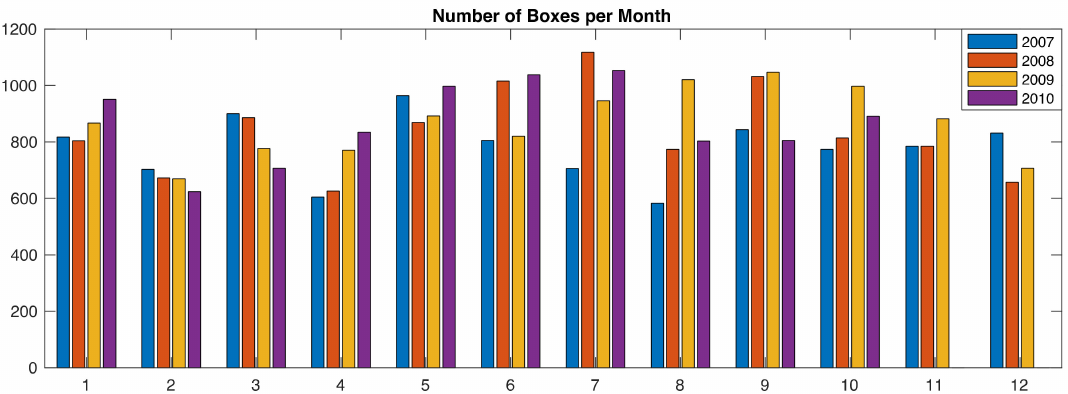
Figure 13. Results of the Box Model for all four years of data, sorted by